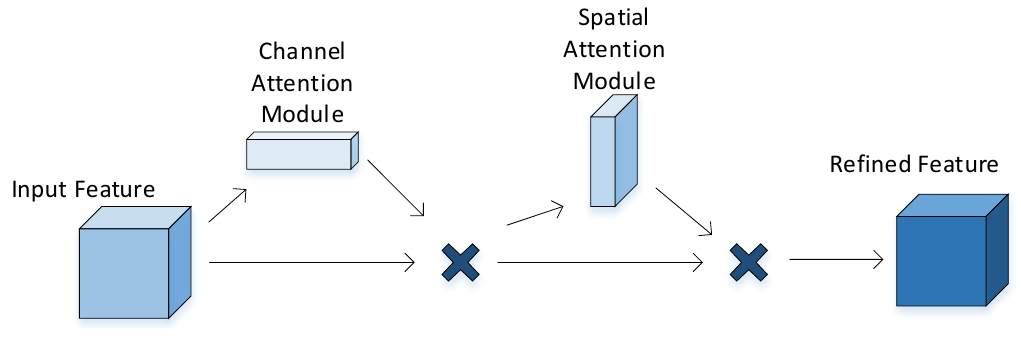
Figure 2. Structure of the CBAM.